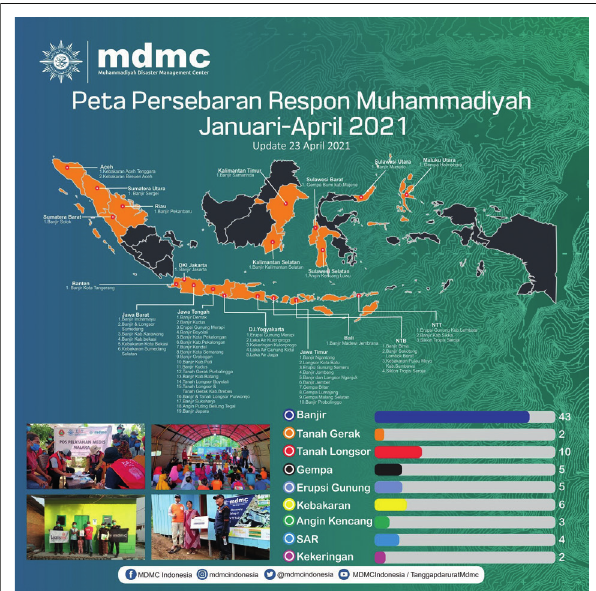
FIGURE 4: Muhammadiyah response beneficiaries from January to April 2021